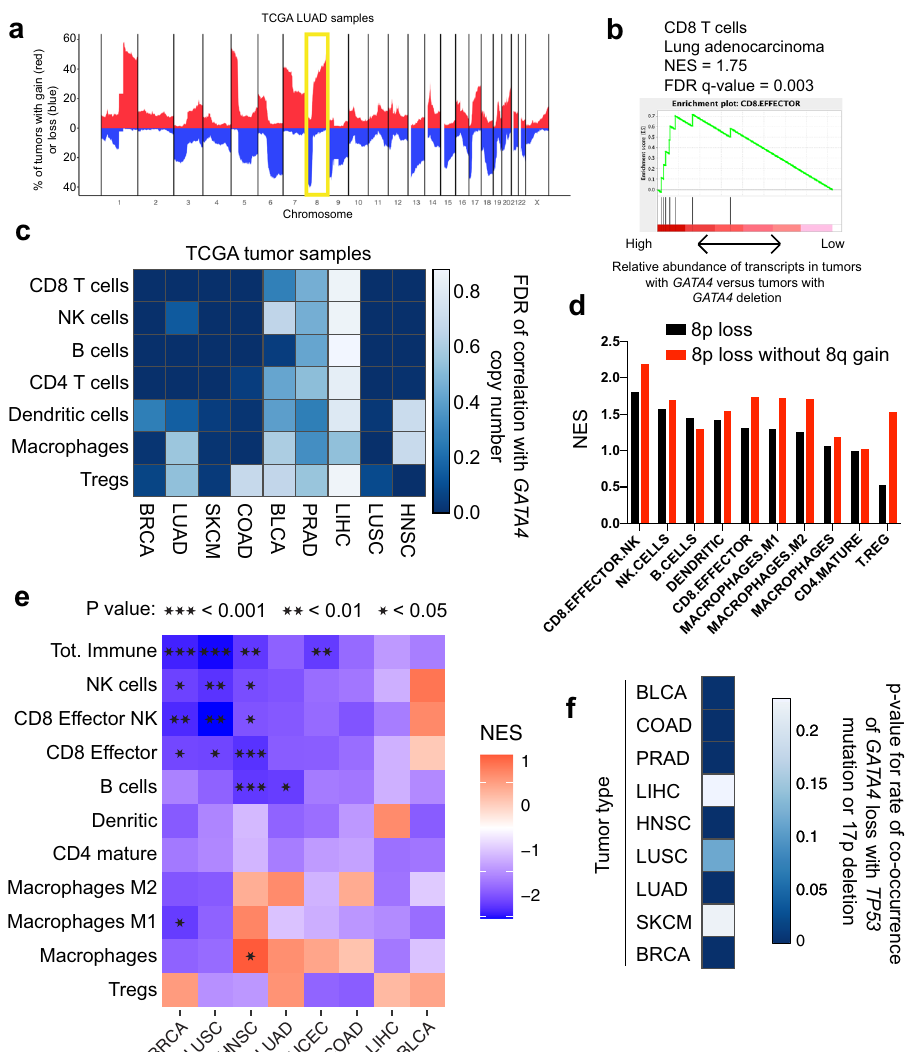
Fig. 3 GATA4 is deleted in human cancer and is associated with the abundance of TILs. a Summary of TCGA data showing the most common chromosomal deletions (blue) and ampli fi cations (red) in human lung adenocarcinoma (LUAD) tumor samples. Chromosome arm 8p contains the human GATA4 gene. Chromosome 8 is highlighted. b CD8 T cell-associated transcripts are decreased in GATA4 -deleted tumors in lung adenocarcinoma. c Analysis of the abundance of tumor-in fi ltrating lymphocytes (TILs) in TCGA tumor samples of various subtypes. Tumor samples were corrected for tumor purity before calling copy number alterations. TCGA RNA-seq data were used to calculate the association between GATA4 copy number and the abundance of TIL subtypes in each tumor type. Color indicates the FDR of the correlation between GATA4 copy number and the abundance of TIL subtypes. Darker colors indicate higher signi fi cance. Abbreviations are breast adenocarcinoma (BRCA; n = 256 GATA4 loss, n = 460 no GATA4 loss), lung adenocarcinoma (LUAD; n = 120 GATA4 loss, n = 319 no GATA4 loss), melanoma (SKCM; n = 20 GATA4 loss, n = 82 no GATA4 loss), colorectal adenocarcinoma (COAD; n = 97 GATA4 loss, n = 167 no GATA4 loss), bladder adenocarcinoma (BLCA; n = 138 GATA4 loss, n = 262 no GATA4 loss), prostate adenocarcinoma (PRAD; n = 147 GATA4 loss, n = 266 no GATA4 loss), liver hepatocellular carcinoma (LIHC; n = 216 GATA4 loss, n = 149 no GATA4 loss), lung squamous cell carcinoma (LUSC; n = 124 GATA4 loss, n = 229 no GATA4 loss), and head and neck squamous cell carcinoma (HNSC; n = 148 GATA4 loss, n = 363 no GATA4 loss). d Analysis of the association of loss of GATA4 /8p with TIL subtypes in samples with or without the co- associated CNA + 8q in colorectal adenocarcinoma. e Extended CNA pro fi le normalization analysis across tissue types with respect to TIL subtype abundance associations. Here we normalized tumor cohorts for all GATA4 //8p-correlated and anticorrelated CNAs in each subtype, beyond just the + 8q co-association. Abbreviations are breast adenocarcinoma (BRCA; n = 127 GATA4 loss, n = 313 no GATA4 loss), lung adenocarcinoma (LUAD; n = 63 GATA4 loss, n = 277 no GATA4 loss), uterine corpus endometrial carcinoma (UCEC; n = 19 GATA4 loss, n = 92 no GATA4 loss), colorectal adenocarcinoma (COAD; n = 47 GATA4 loss, n = 131 no GATA4 loss), bladder adenocarcinoma (BLCA; n = 68 GATA4 loss, n = 202 no GATA4 loss), liver hepatocellular carcinoma (LIHC; n = 148 GATA4 loss, n = 114 no GATA4 loss), lung squamous cell carcinoma (LUSC; n = 60 GATA4 loss, n = 200 no GATA4 loss), and head and neck squamous cell carcinoma (HNSC; n = 73 GATA4 loss, n = 323 no GATA4 loss). f GATA4 copy number loss is co- associated with TP53 loss (mutation or deletion) in most tumor types. P -values are calculated using hypergeometric